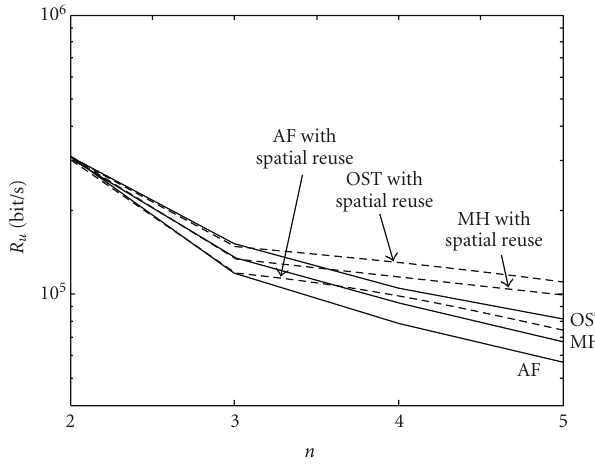
Figure 5: Per node uniform capacity R u versus the number of nodes n for di ff erent transmission